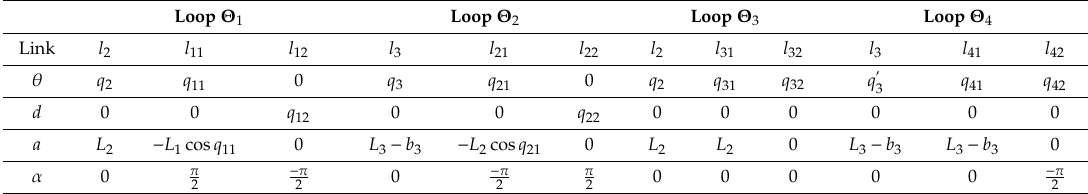
Table 1. The D-H notations of the four local closed